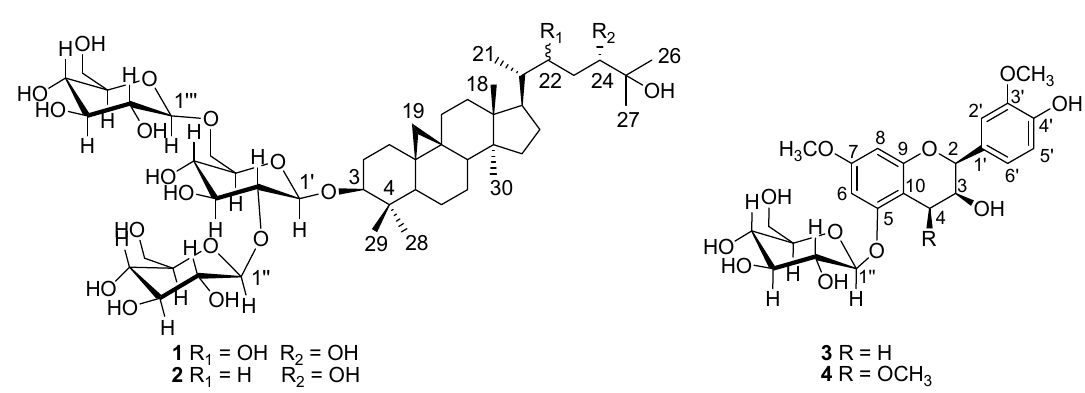
Figure 1. Chemical structures of 1 – 4